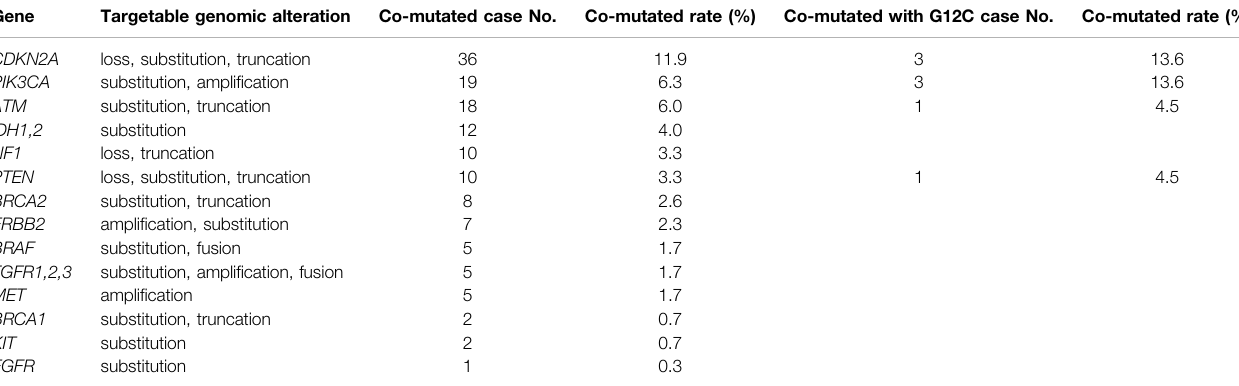
TABLE 3 | Targetable alterations co-mutated with